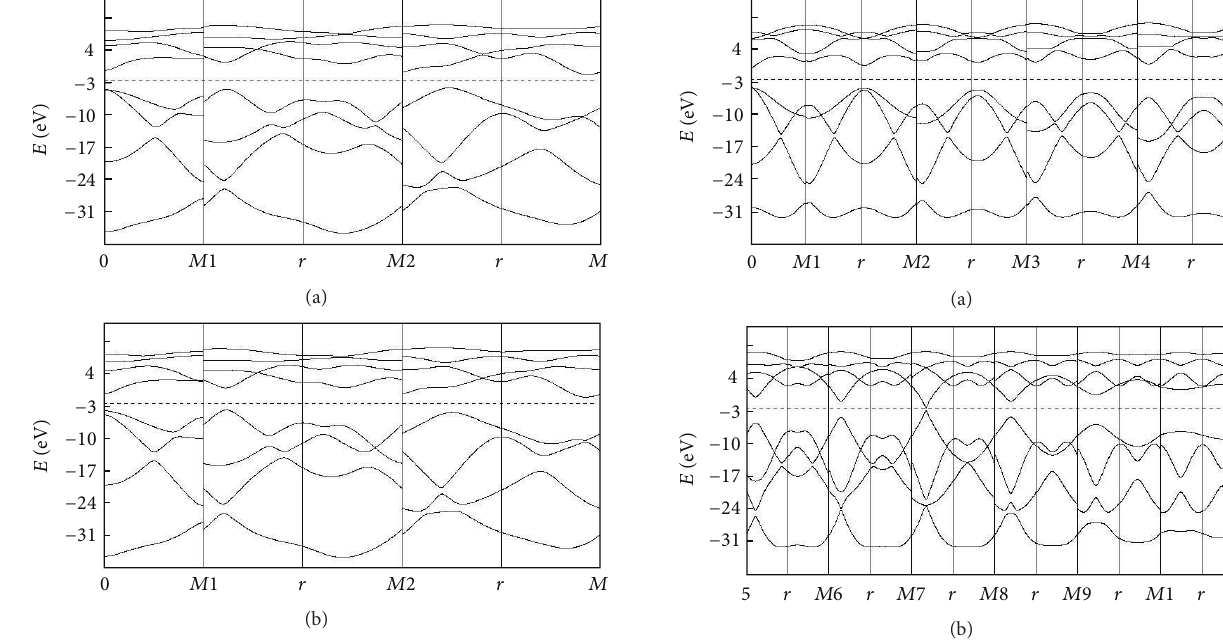
Figure 8: Band structure of [(21,0),91] SWSiNT for full set of allowed k 𝜙 , that is, [(−𝑟/21, 1/2) → (−𝑟/21, 0) | (𝑟/21, 0) → (𝑟/21, 1/2)] , with arrangements (a) 𝑟 = 0 , 𝑟 = ±1, ±2,±3, ±4 and (b) 𝑟 = ±5,±6, ...,±10